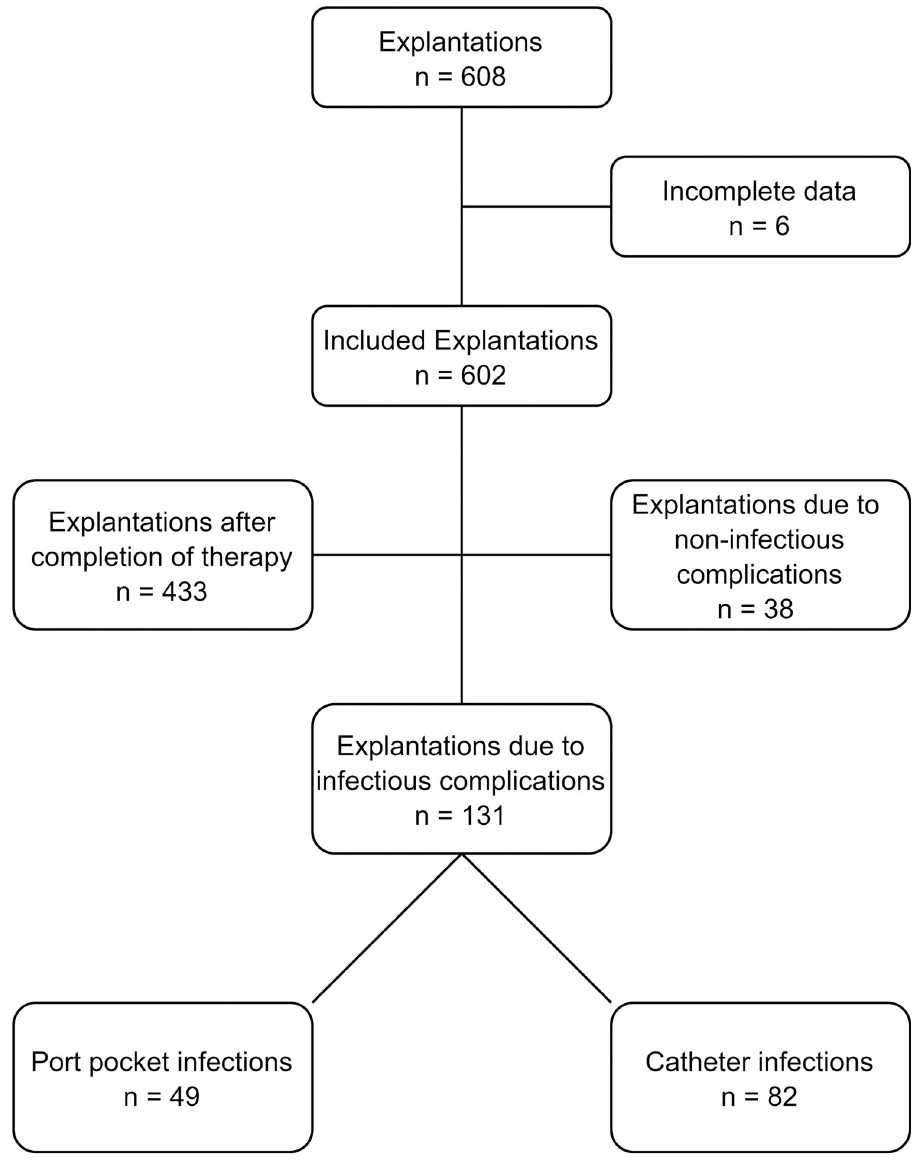
Fig 1. Case selection flow